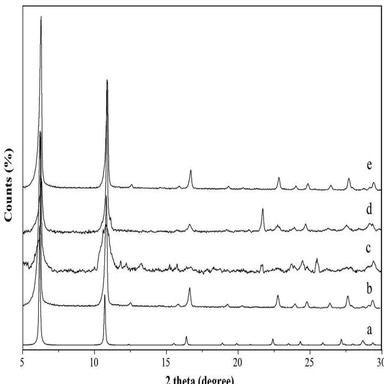
PXRD patterns of as-synthesized STA-12(M) samples: simulated XRD pattern of STA-12 (a), Mn (b), Fe (c), Co (d), Ni (e).